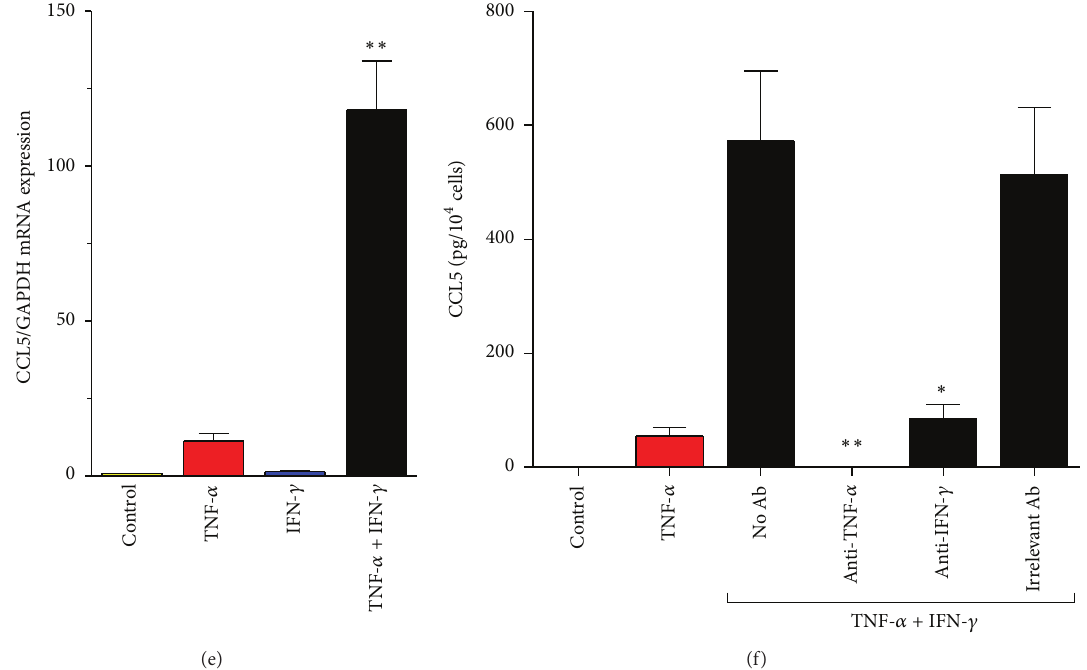
Figure 2: CCL5 induction in HPFB stimulated with TNF- 𝛼 and IFN- 𝛾 . (a) Kinetics of CCL5 secretion by HPFB treated with TNF- 𝛼 (1000pg/mL)andIFN- 𝛾 (25U/mL)aloneorincombination.Asterisksrepresentasignificantdifferencecomparedwiththepredictiveadditive values at each time point ( 𝑛 = 6 ); (b) dose effect of IFN- 𝛾 alone or with TNF- 𝛼 (1000pg/mL; 𝑛 = 7 ); (c) dose effect of TNF- 𝛼 alone or with IFN- 𝛾 (25 U/mL; 𝑛 = 5 ). B and C cells were stimulated for 48 hours. Asterisks represent statistically significant differences compared to the predictive additive values; (d) kinetics of TNF- 𝛼 and IFN- 𝛾 -induced CCL5 mRNA. Cells were treated with TNF- 𝛼 and/or IFN- 𝛾 for the times indicated. Results of an exemplary experiment of two performed; (e) magnitude of CCL5 mRNA expression in HPFB treated for 24 hours with TNF- 𝛼 and/or IFN- 𝛾 . Results of 4 experiments with cells from separate donors. Asterisks represent a significant difference compared to the predictive additive value. D and E cells were treated with TNF- 𝛼 at 1000pg/mL and IFN- 𝛾 at 25 U/mL. CCL5 mRNA expression relative to that of GAPDH was quantified with real-time PCR; (f) effect of neutralizing anti-TNF- 𝛼 or anti-IFN- 𝛾 antibodies on synergistic CCL5 release by HPFB. Cells were incubated with antibodies (all at 1 𝜇 g/mL) for 48h. Asterisks represent a significant difference compared with cells treated with a combination of TNF- 𝛼 (1000pg/mL) and IFN- 𝛾 (25 U/mL) in the absence of antibodies ( 𝑛 = 4